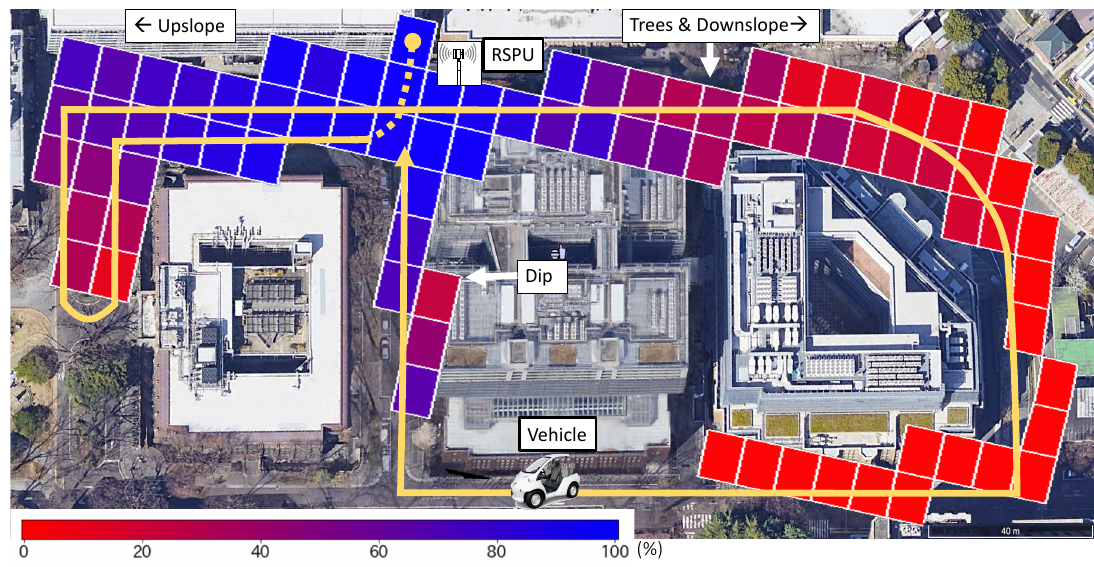
Figure 8. Packet delivery ratio R pd in field experiment.